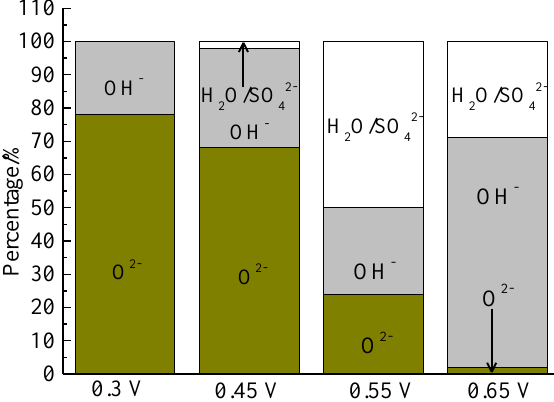
Figure 16. Distribution of oxygen containing species on bornite surface after treating by different potential of 0, 0.3, 0.45, 0.55, 0.65 V, respectively (Implemented on the model of ESCALAB 250Xi of Al Kα X-ray source with 20 eV constant pass energy and 0.1 eV/step; Fitted by Thermo Avantage 5.52, C 1s 284.8 eV as reference, Shirley method, Gaussian-Lorentzian function).